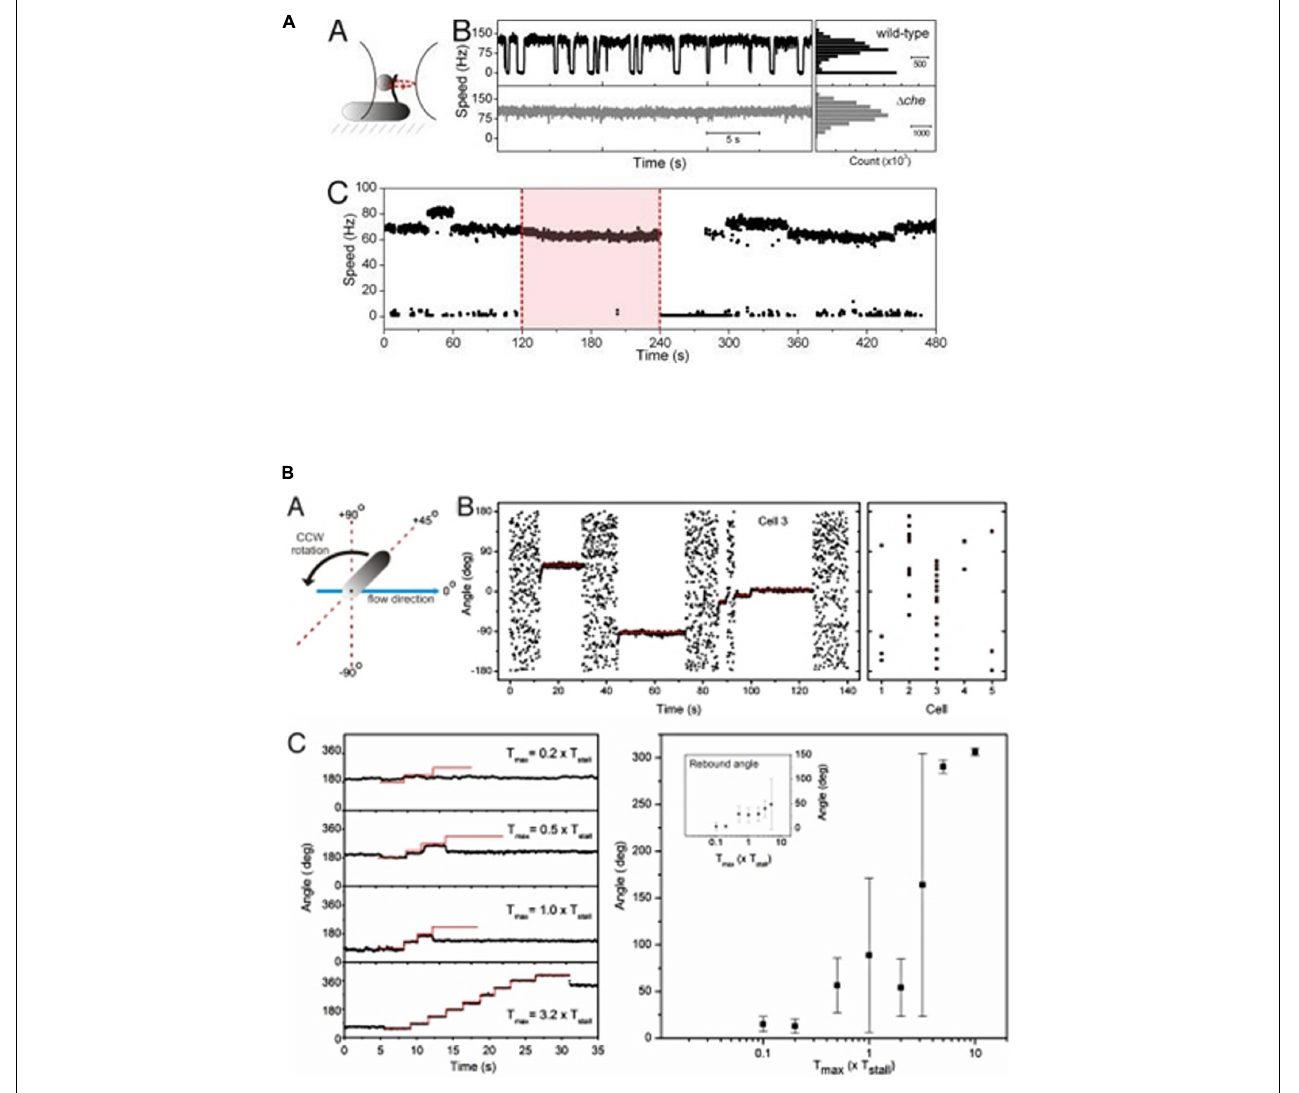
FIGURE 4 | Tethered cell analysis of R. sphaeroides motor behavior. (A) Behavior of bead attached to a truncated filament of a wt and a non-chemotactic mutant. Wt motors show long periods of smooth swimming with occasional stops, while non-chemotactic mutants show constant smooth swimming. (C) Longer timescale shows a tethered wt cell rotating smoothly with occasional increases in speed. Pink box shows addition of attractant and loss of stops, removal results in stopped cell and adaptation. (B) Shows cell tethered by its flagellum and stopped by large chemosensory stimulus and the force required to rotate the cell (details in Pilizota et al.,